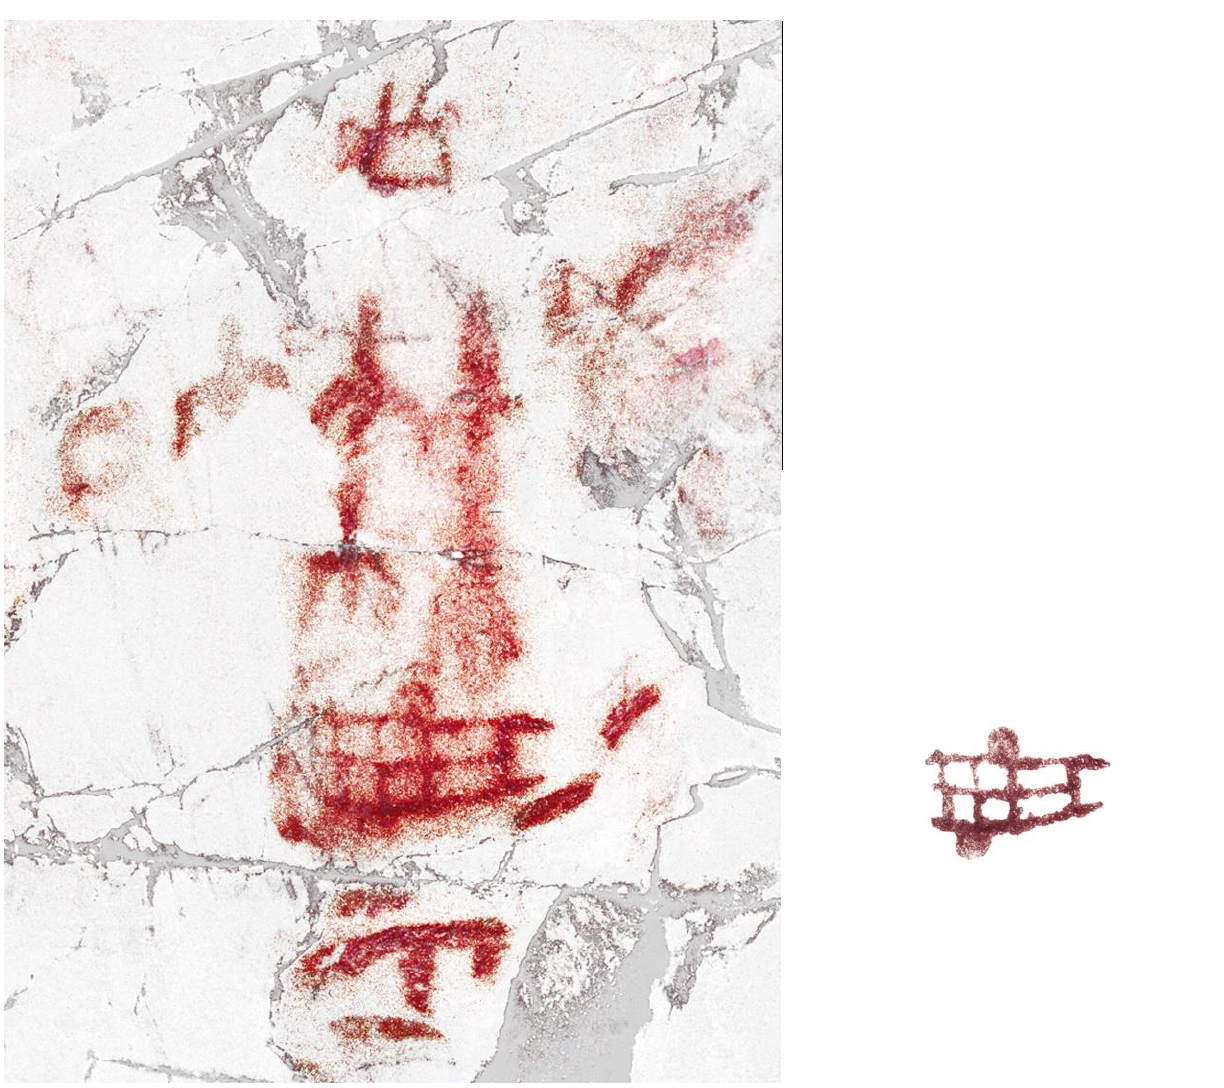
Figure 2. Tracing of panel 1 in the shelter of El Covacho and detail of the figure of the cart